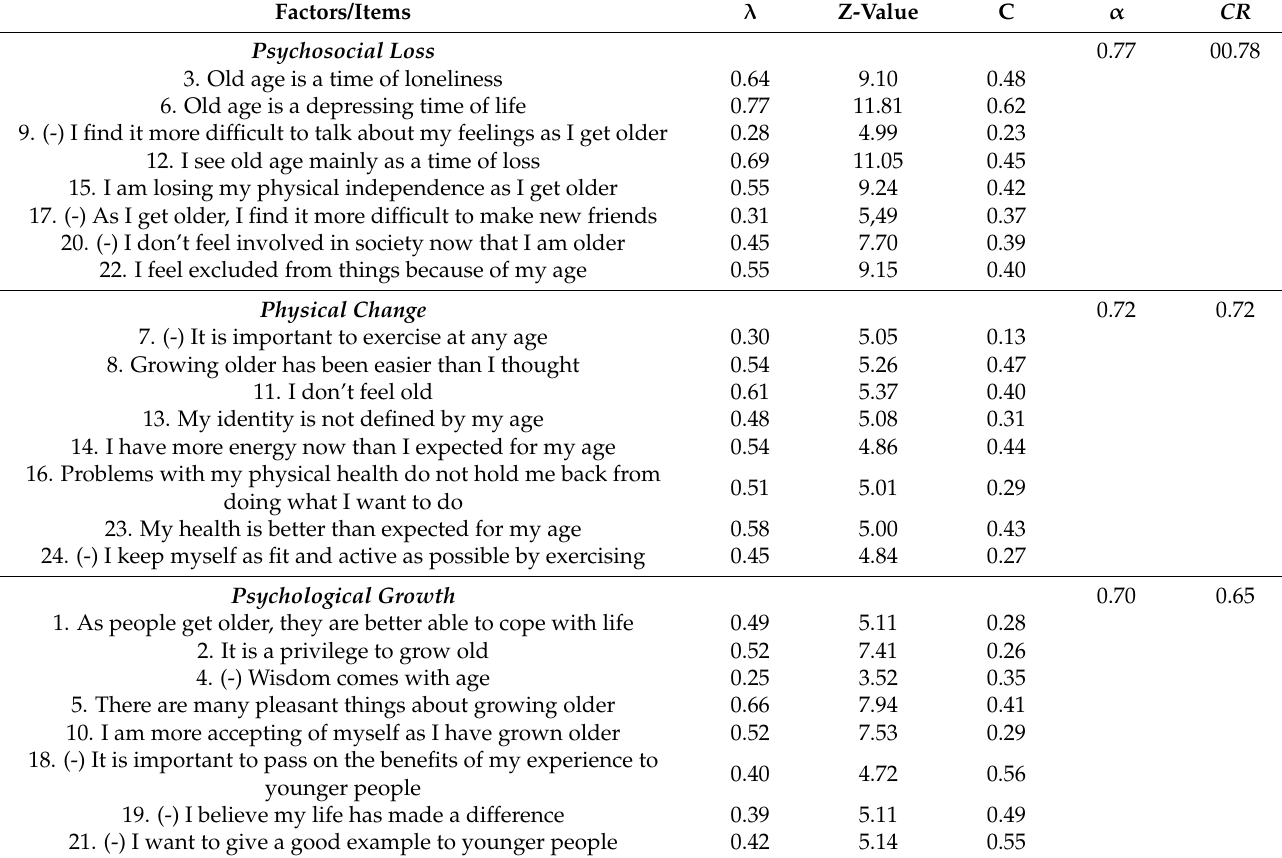
Table 3. Factor loadings, Z-values, communalities of the original scale with 24 items, and Cronbach alpha and composite reliability of the re-specified model of the AAQp with 15